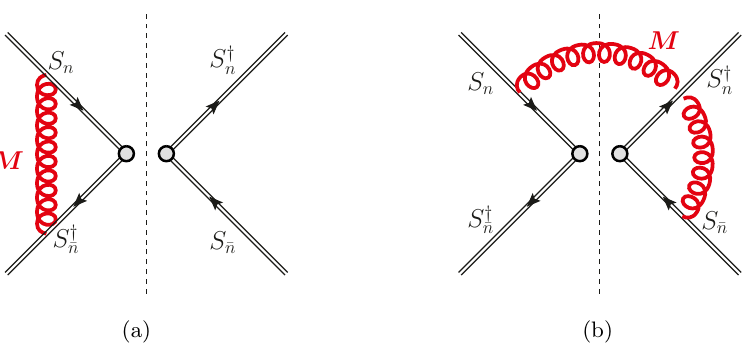
Figure 21 . Soft function corrections for a massive gluon at one-loop. The associated mirror diagrams need to be included in